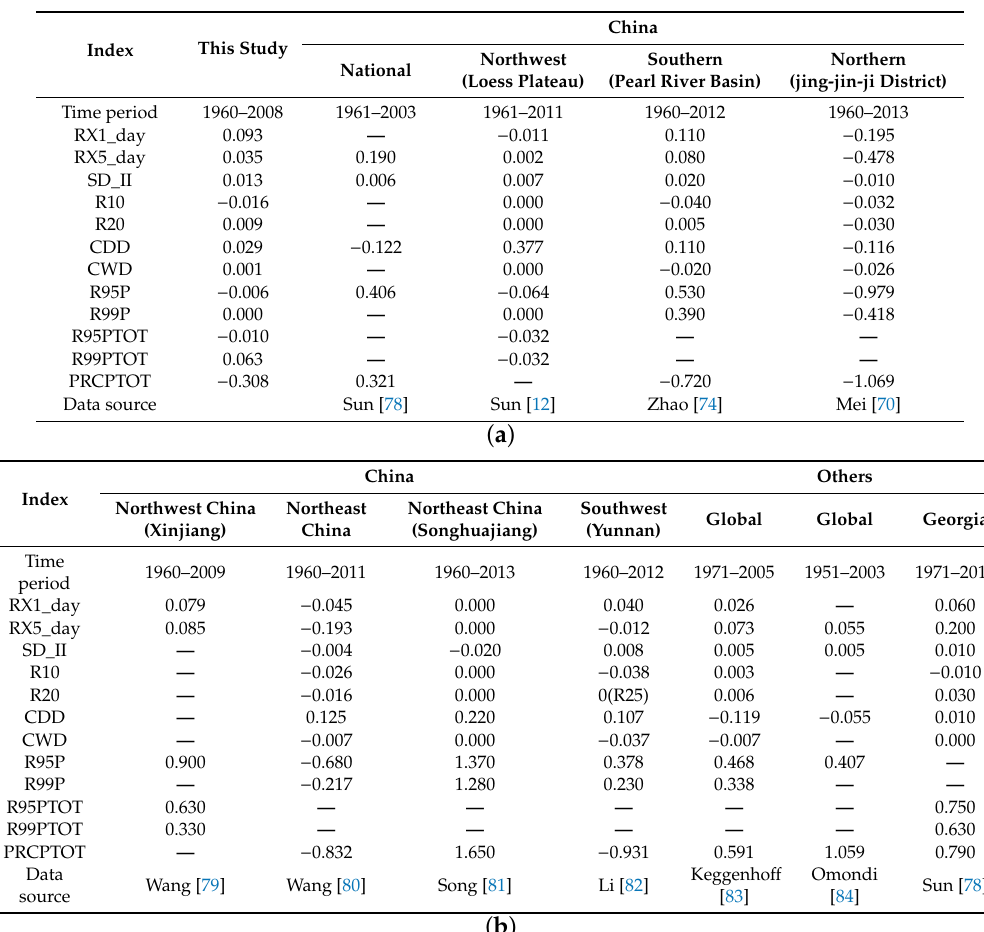
Table 4. ( a ) Trends of extreme precipitation indices from this study and other works. ( b ) Trends of extreme precipitation indices from this study and other